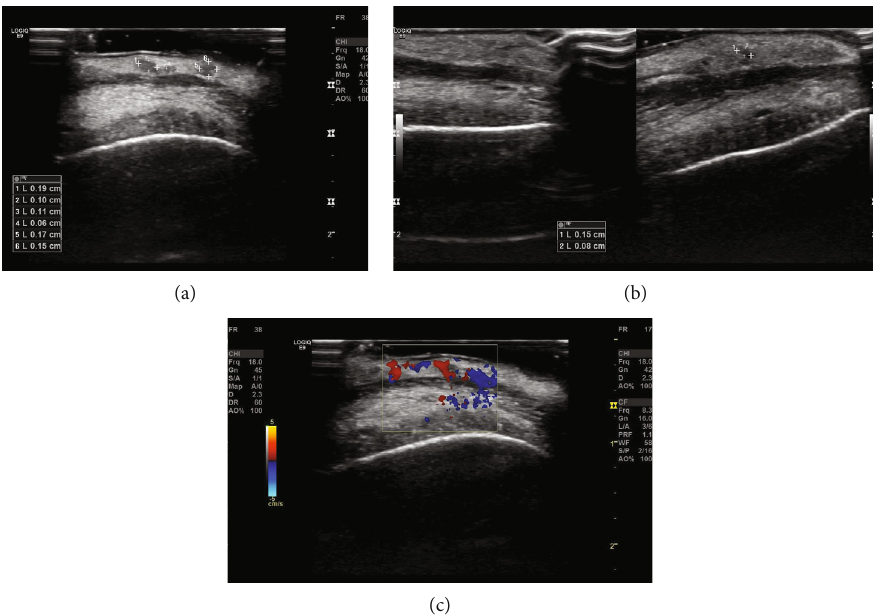
Figure 3: (a, b) Adjacent tiny lesions on the right and left sides of the lip. (c) The color Doppler was suggestive of an avascular anechoic lesion.